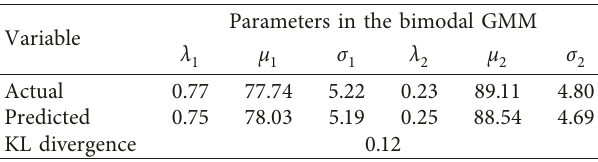
Table 8: Coefficient table of the multiple linear regression model predicting μ 1